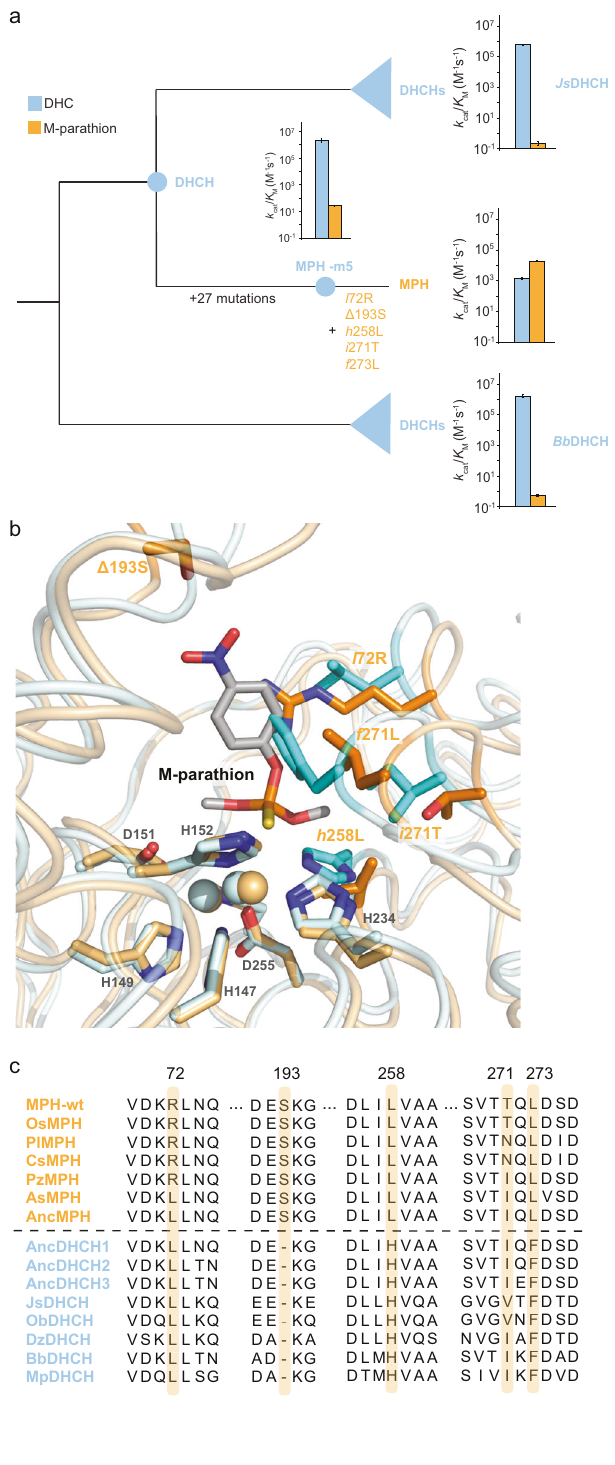
Fig. 1 Functional evolutionary history of MPH gene family. a Phylogenetic reconstruction of MPH family and its DHCH relatives. The catalytic activities (kcat/KM) of the enzymes for dihydrocoumarin and methylparathion are displayed in bar graphs (error bars show standard deviation). The fi ve key mutations between the ancestral DHCH enzyme and MPH are labeled in orange on the branch between MPH-m5 and the derived MPH. The schematic phylogenetic was constructed using previously published phylogenetic reconstruction 11 . b Overlay of the cartoon representations of the crystal structures of DHCH (cyan, PDB ID: 6c2c) and MPH (orange, PDB ID: 1p9e). The fi ve key mutations are highlighted as sticks and labeled in orange. The two active site metal ions are shown as spheres. Residues involved in coordinating the active site metal ions are highlighted as sticks and labeled in gray. The docking pose of the methyl-parathion substrate is shown as sticks. c A cropped multiple sequence alignment of representative sequences of extant MPH, DHCH, and resurrected ancestral enzymes. Residues at the positions where the fi ve active site mutations have occurred between DHCH and MPH are highlighted in orange. c is adapted from Yang et al.